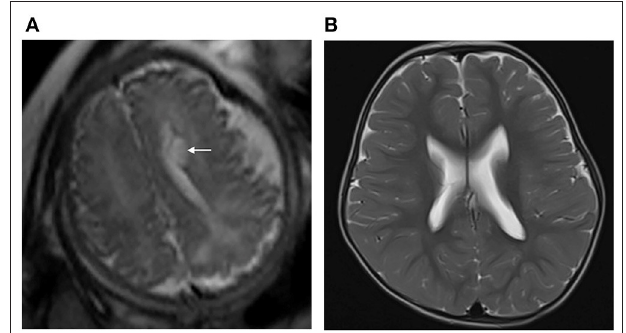
FIGURE 4 | (A) Pregnant woman, 22 years old, with a fetus of 36 weeks’ gestation. Fetal brain MRI shows a unilateral isolated periventricular pseudocyst (PVPC) located at the external angle of the lateral ventricle (white arrow); the anteroposterior diameter and height are 0.9 and 0.5cm, respectively. (B) Female infant, with a history of hypoxic-ischemic encephalopathy (HIE) and asphyxia at birth. At the age of 30 months, the brain MRI showed the PVPC disappeared, and there were no changes in the thalami and basal ganglia related to the previous HIE. The GDS test showed a moderate neurodevelopmental disability in the Adaptive, Gross Motor, and Fine Motor parameters, and mild neurodevelopmental disability in the Language and Personal-Social parameters (DQ:Adaptive: 46, Gross Motor: 50, Fine Motor: 40, Language: 63, and Personal Social: